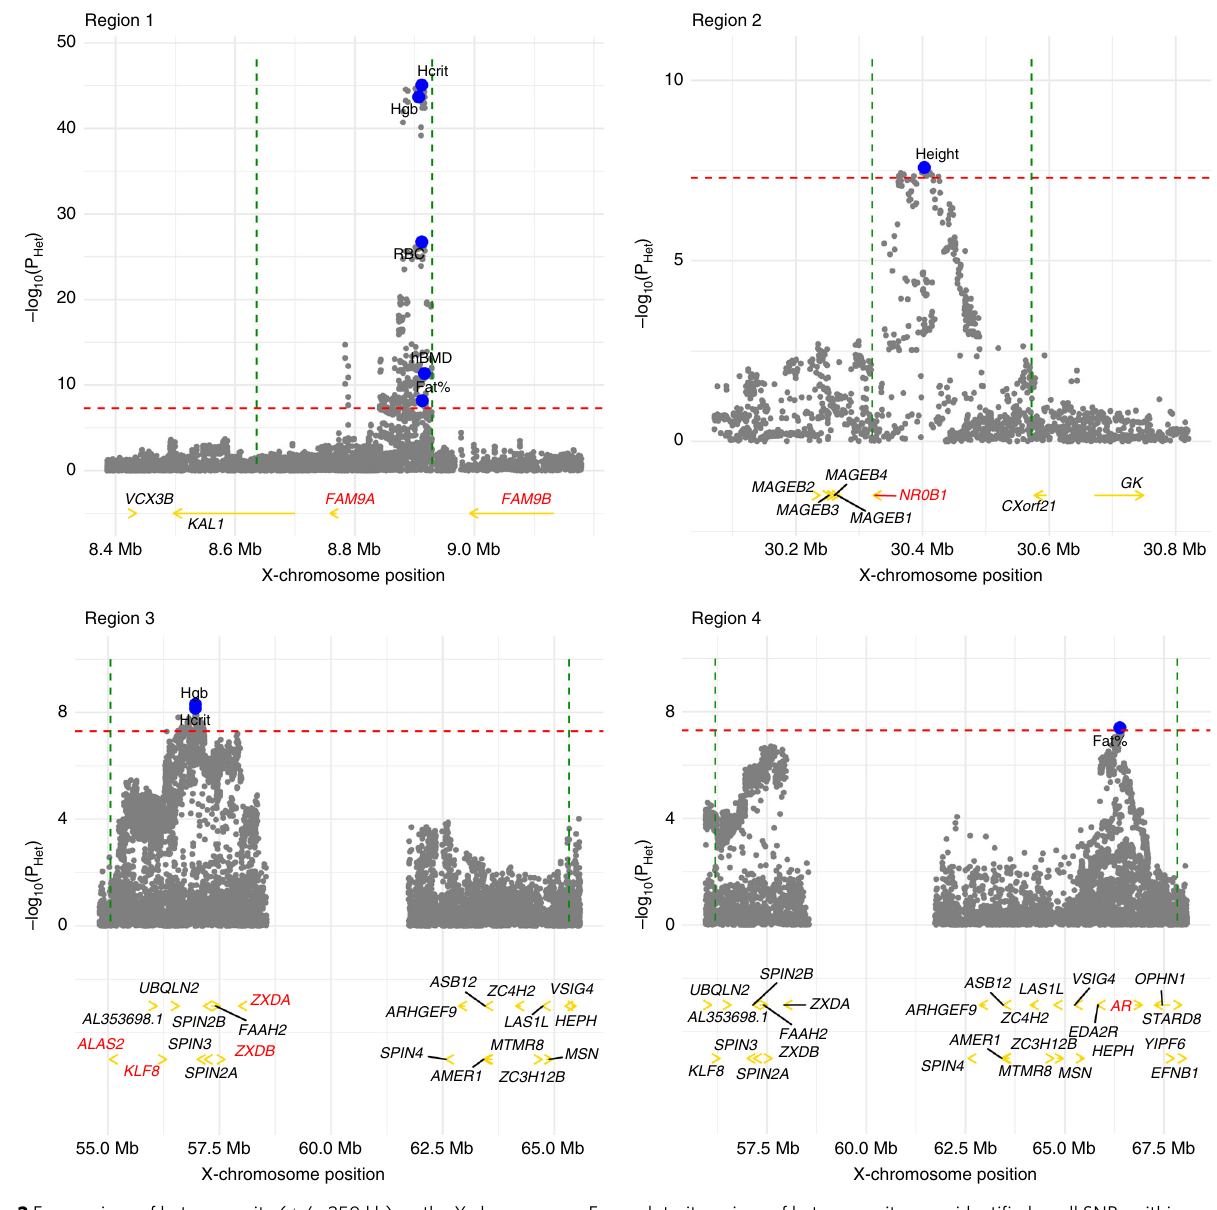
Fig. 2 Four regions of heterogeneity ( + / − 250 kb) on the X chromosome. For each trait, regions of heterogeneity were identi fi ed as all SNPs within a region of linkage disequilibrium (LD) R 2 > 0.05 to the SNP with highest evidence of signi fi cant heterogeneity (Supplementary Table 4). In each region the heterogeneity P -values ( P Het ) are plotted (grey dots) for all traits with signi fi cant heterogeneity in that region. The top SNPs for each trait are shown in blue. The genes discussed in the Supplementary Note 2 are highlighted in red. In region 3, only the ALAS2 gene and genes with X-chromosome position > 56 Mb are shown for simplicity (the omitted 15 genes are: ITIH6 , MAGED2 , TRO, PFKFB1 , APEX2 , PAGE2B , PAGE2 , FAM104B , MTRNR2L10 , PAGE5 , PAGE3 , MAGEH1 , USP51 , FOXR2 , RRAGB ). The red dashed line represents the signi fi cance threshold ( P = 5.0 × 10 – 8 ). The green dashed lines represent the Het boundaries of the regions. Traits: Haematocrit percentage (Hcrit), haemoglobin concentration (Hgb), red blood cell (erythrocyte) count (RBC), heel bone mineral density T-score (hBMD), body fat percentage (Fat%), standing height